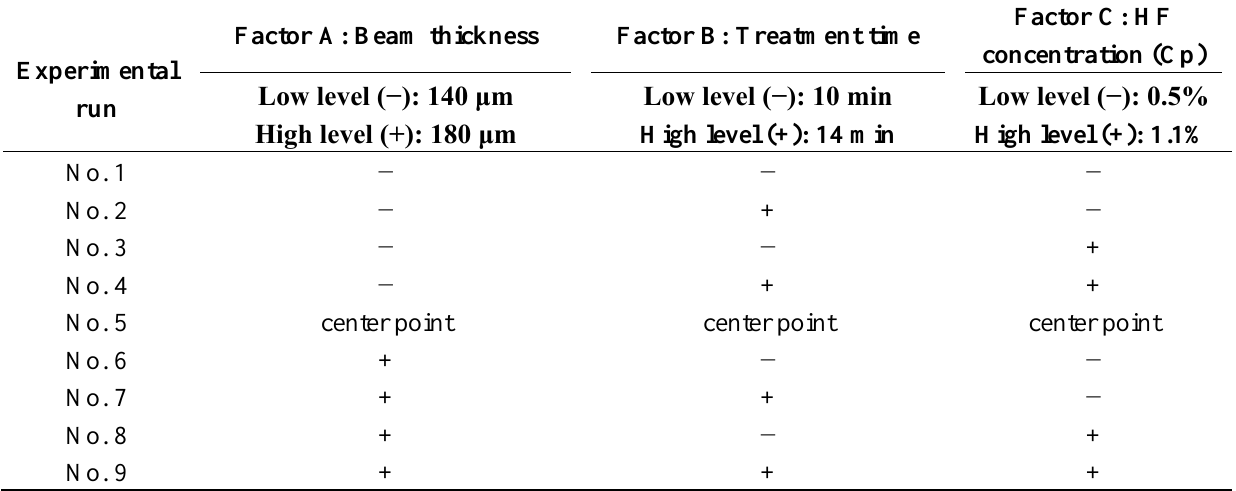
Table 1. An overview of the experimental conditions used for the three-factor two-level full factorial. Factor A: Beam thickness Factor B: Treatment time Experimental Low level (−): 140 μm run